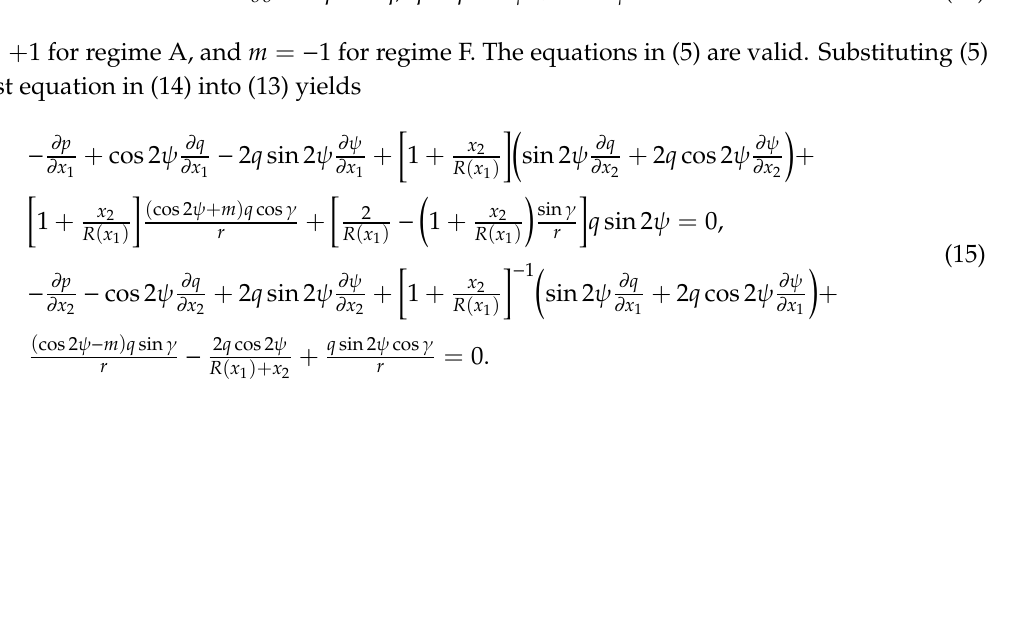
Figure 3. Orthogonal coordinate system ( x 1 , x 2 ) near a given curve (S–line) under axially symmetric conditions.